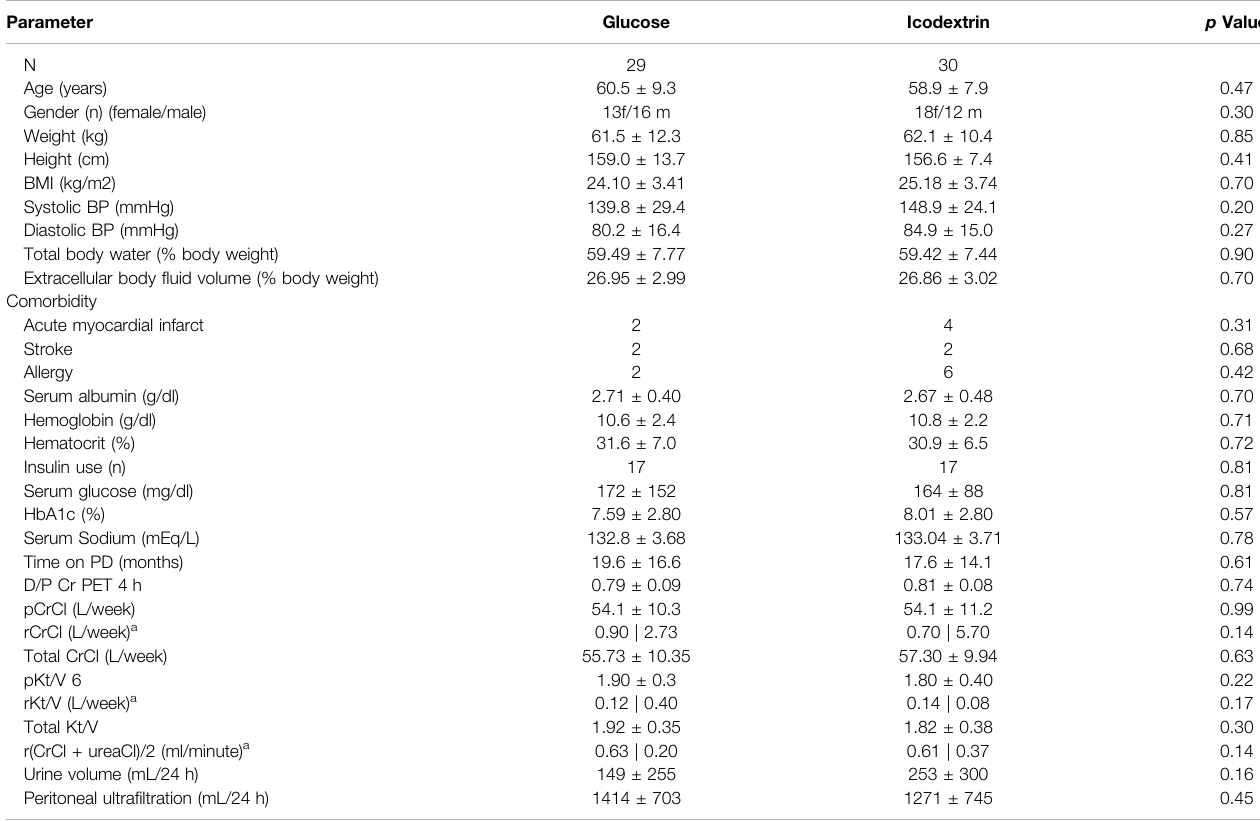
TABLE 1 | Demography, clinical and biochemical characteristics of patients at baseline.